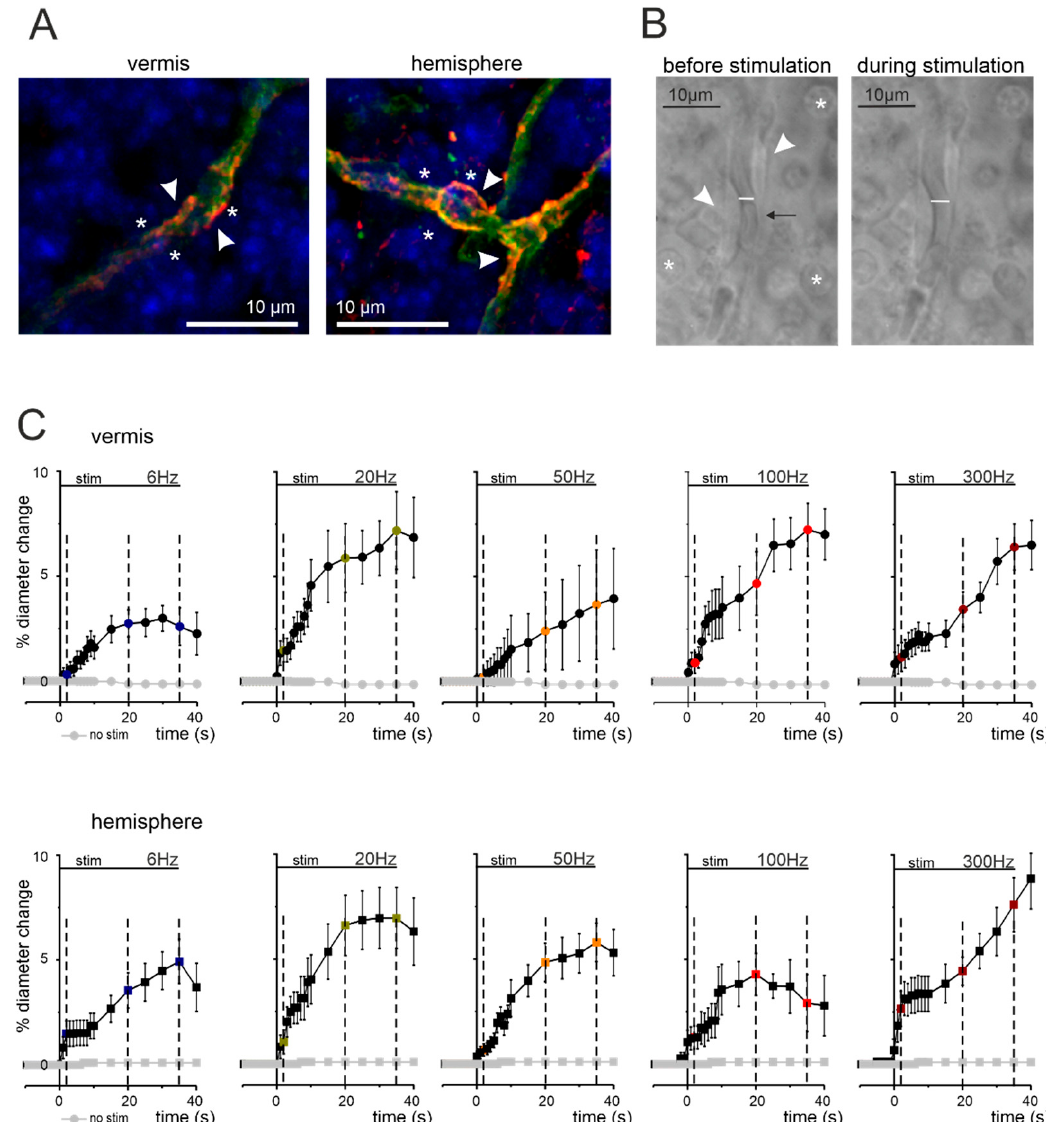
Figure 1. Anatomo-physiological correlations of NVC in the cerebellar granular layer. ( A ) Confocal fluorescent images of cerebellar slices stained for IB4 (green), NG2 (red), and DAPI (blue) to identify capillaries, pericytes, and cell nuclei, respectively. In both vermis and hemisphere, granule cells (asterisks) are in proximity of pericytes (arrowheads) located on capillary endothelium (green). ( B ) Bright-field images taken before and during mossy fiber stimulations at 50 Hz (vermis). The pericytes (arrowheads) are visible near granule cells (asterisks) and the capillary walls can be easily identified. The internal diameter changes in response to stimulation (white bar). The arrow indicates a red blood cell that moves inside the capillary as a consequence of blood vessel motility. ( C ) Average time courses of capillary dilation during mossy fibers activation at different frequencies in vermis and hemisphere. The figure shows the average percent change in capillary diameter size in the different conditions tested for the vermis lobule V and hemisphere lobule VI. Mossy fibers were stimulated for 35 s at 6, 20, 50, 100, and 300 Hz (stim bar). The dashed lines indicate the time points at 2, 20, and 35 s, used to analyze dilation in the subsequent analysis. In each panel, the dilation at the end of stimulus was significantly different compared to pre-stimulus baseline (see Table S1 in Supplementary Materials). In both panel sets, grey dots represent stability recordings in which stimulation was not delivered ( n =